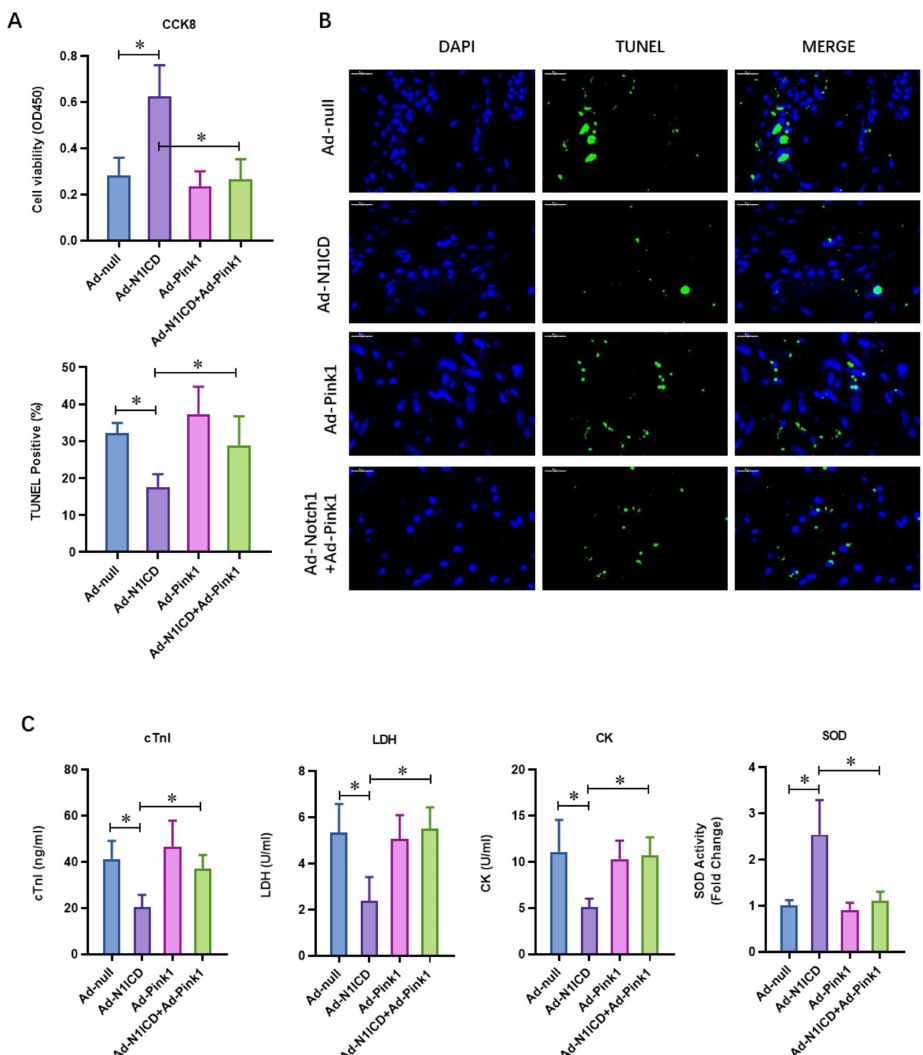
Figure 5. Pink1 over-expression impaired the protective effect of N1ICD against hypoxia/reoxygenation-induced injury in neonatal cardiomyocytes. ( A ) The cellular viabil- ity was detected by CCK-8 assay; ( B ) the percentage of apoptotic neonatal cardiomyocytes was analyzed by TUNEL staining; ( C ) the level of cTnI, LDH, CK, and SOD in the culture medium was also detected by ELISA kits at the end of the reperfusion to assess myocardial injury; N = 3; * p < 0.05 versus indicated